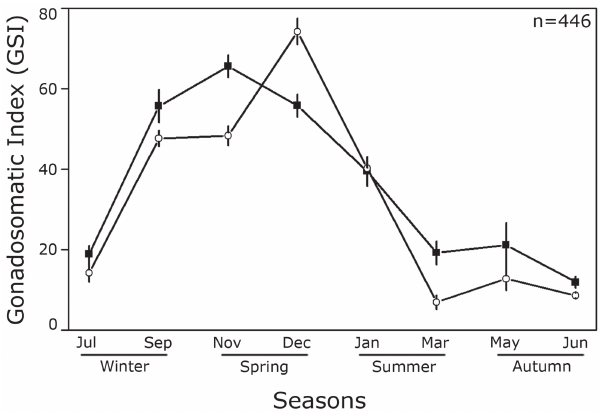
Fig. 4. Mean values (± standard error) of gonadosomatic index (GSI) among months and seasons (black square = females; white circle = males) of Cetengraulis edentulus in Guanabara Bay.